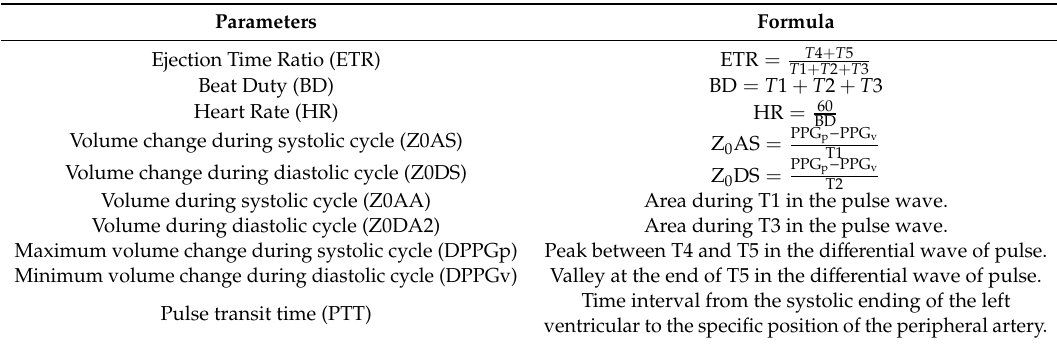
Figure 2. ( a ) The pulse wave, ( b ) The differential wave of pulse. Table 1. Parameter definition of the pulse